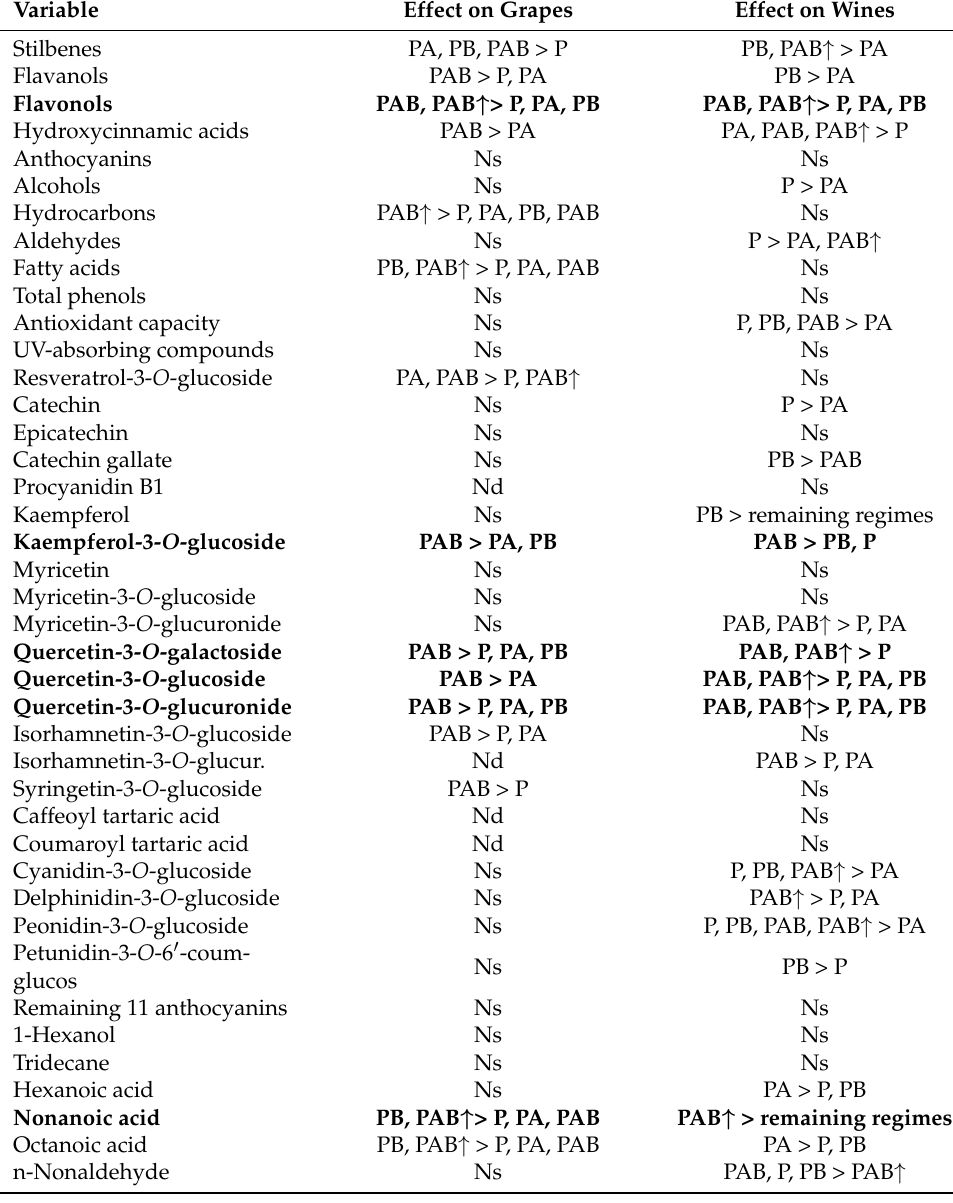
Table 3. A comparison of the effects of UV radiation on 51 variables measured in both grapes [9] and the resulting wines (this study). Grapes were exposed to five different radiation regimes: P (only PAR), PA (PAR + UV-A), PB (PAR + UV-B), PAB (PAR + UV-A + UV-B), and PAB ↑ (PAR + UV-A + enhanced UV-B). Ns, no significant effect of radiation regime in one-way ANOVA. Nd, significant effect of radiation regime in one-way ANOVA, but no significant differences between treatments in a post hoc Tukey test. In bold type, variables showing similar significant responses in both grapes and